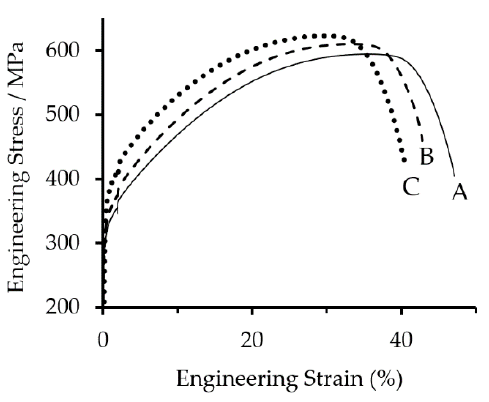
14 of 20 Table 7. Dislocation density, 𝜌 , calculated using Equation (1). Values of θ were measured during EBSD of the as-stabilized material, and s is the step size of the EBSD scan. Sample